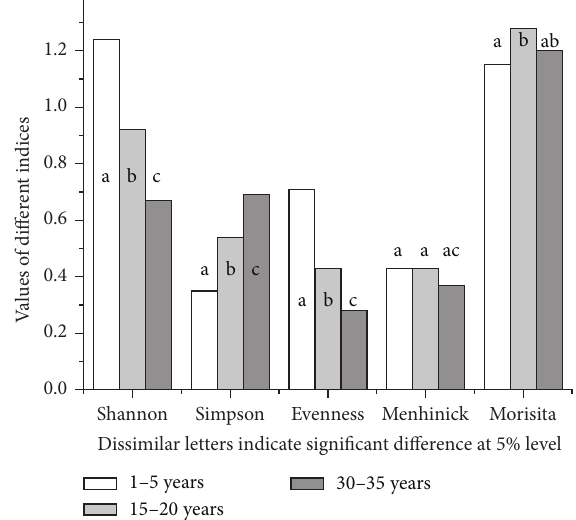
Figure 9: Showing the variation among diversity and dispersion indices in the three age groups of pineapple